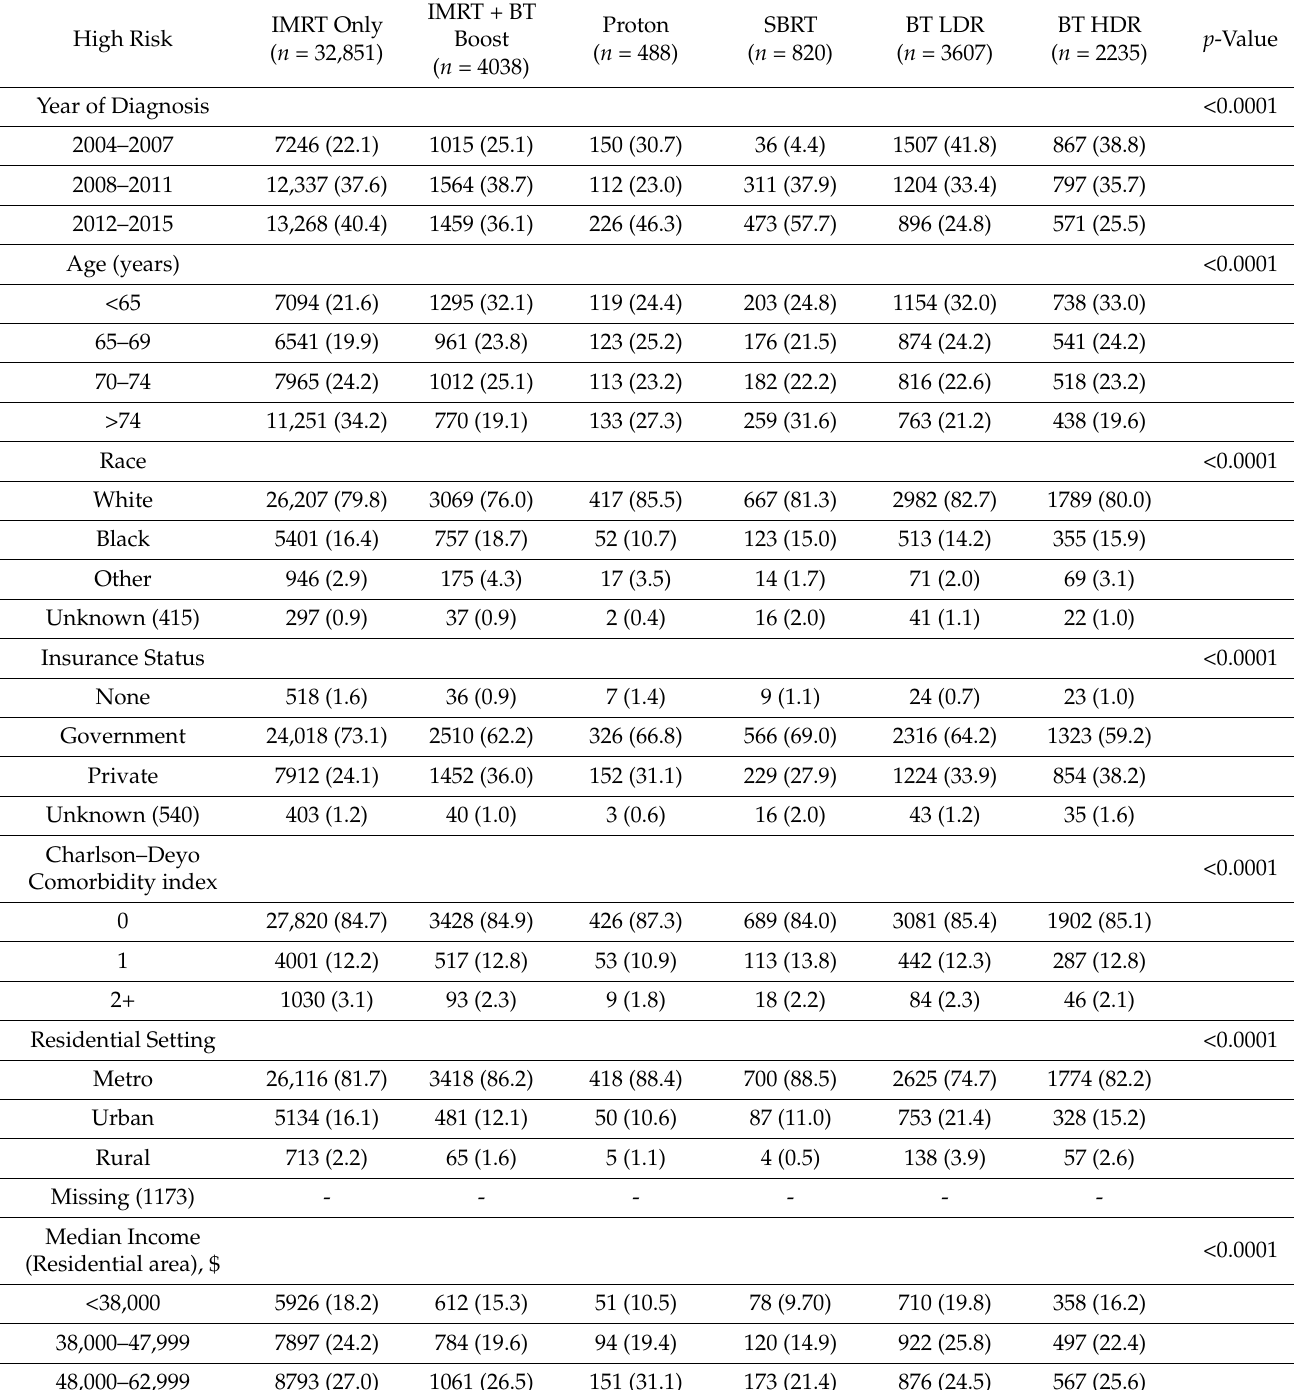
Table 5. Comparative utilization of the six treatment modalities for high-risk prostate cancer